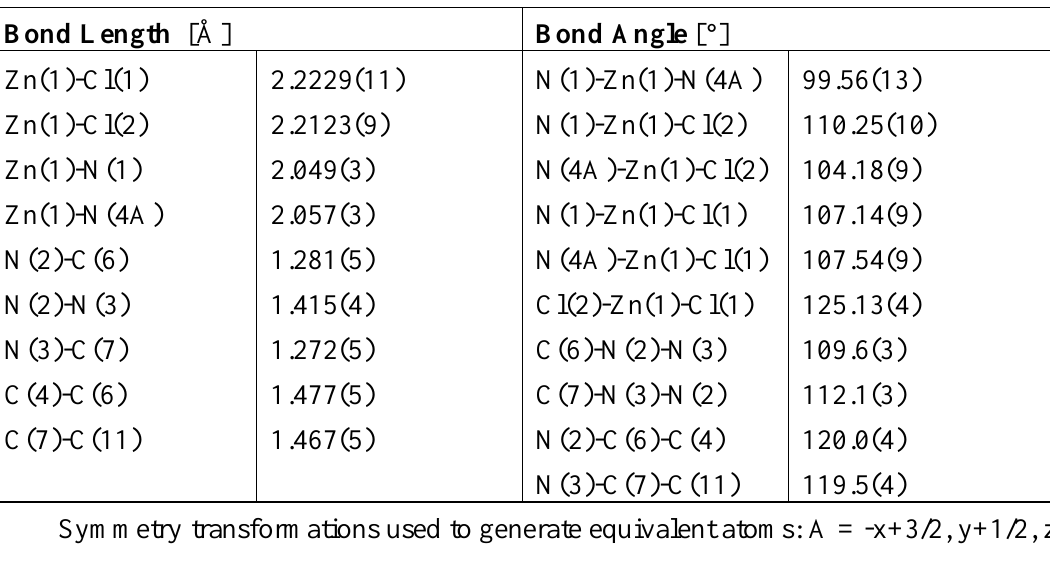
Table 1. Selected bond lengths and angles around the Zn(II) for compound 1.